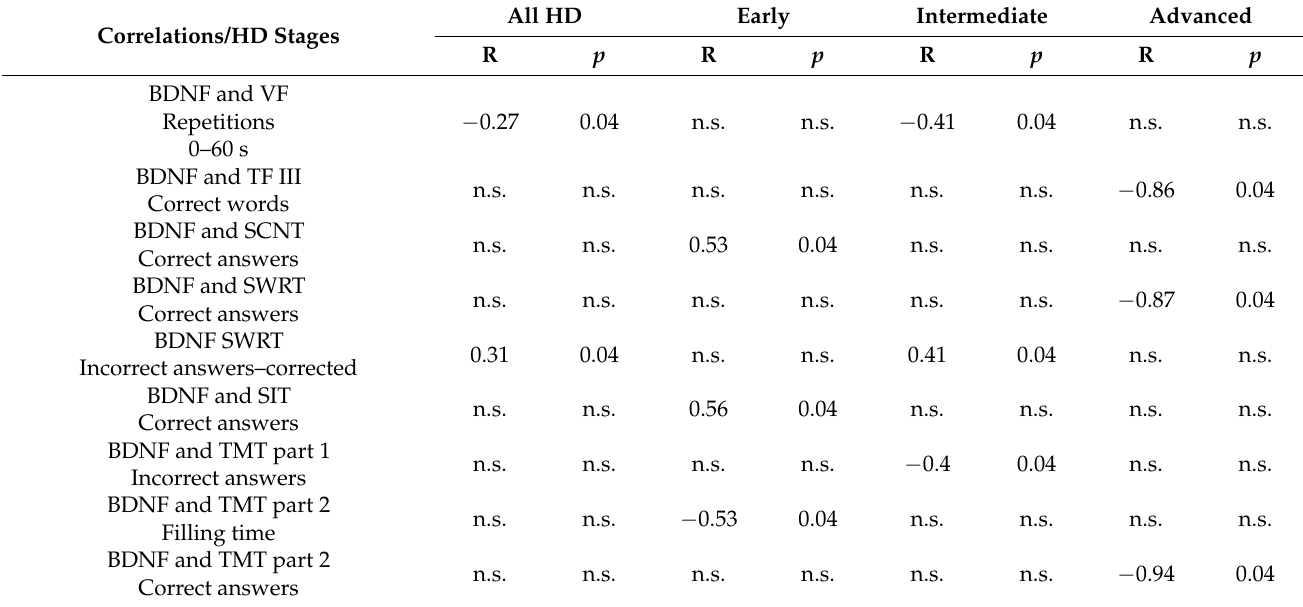
Table 5. Correlations between plasma levels of BDNF and cognitive functions determined using Spearman’s test. Correlations/HD